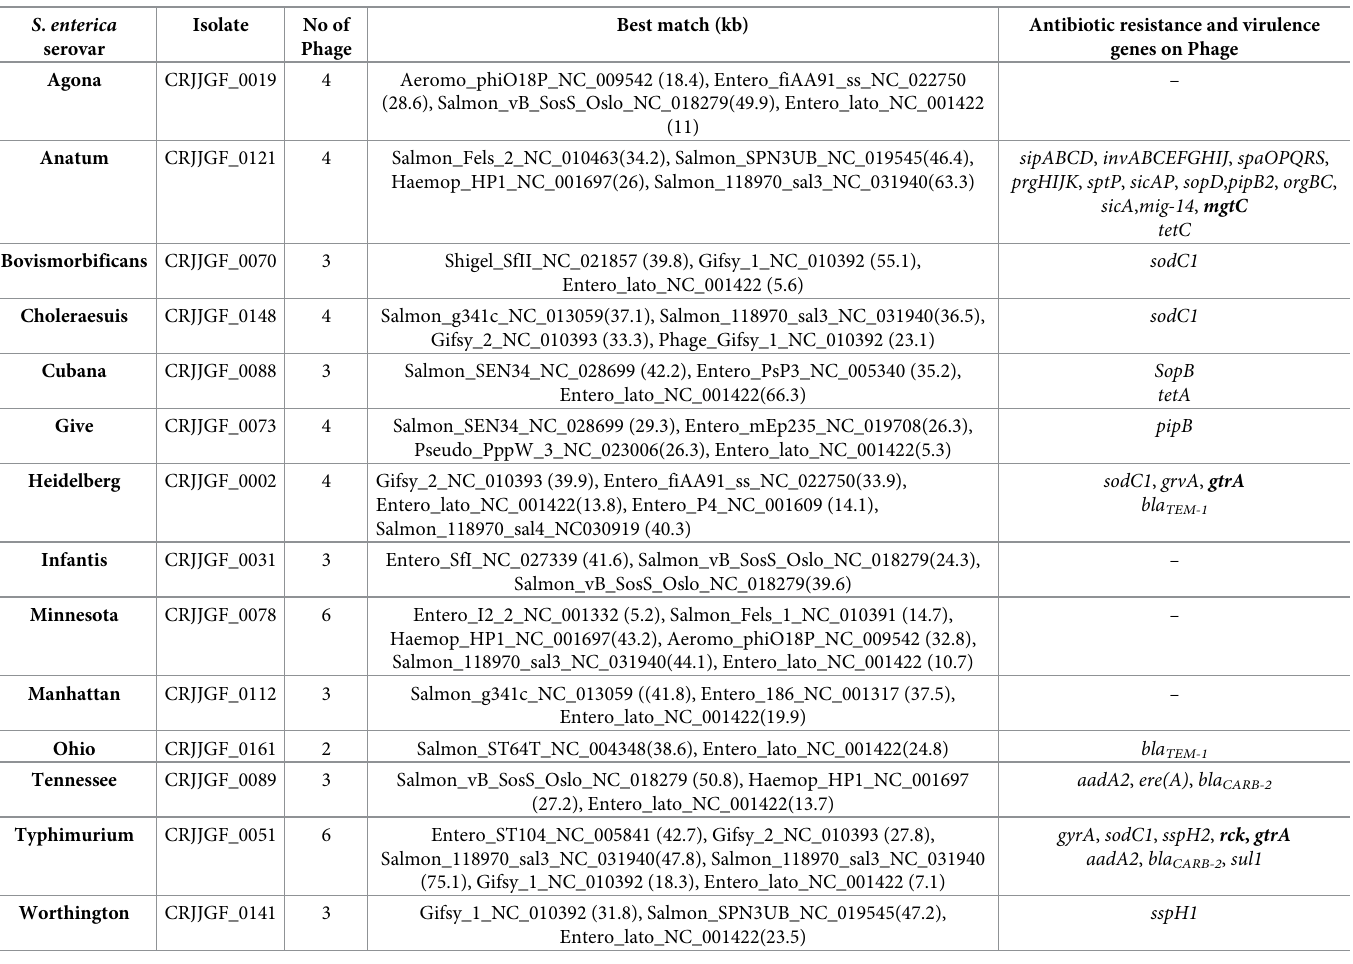
Table 4. Phage harboring virulence and resistance genes in Salmonella